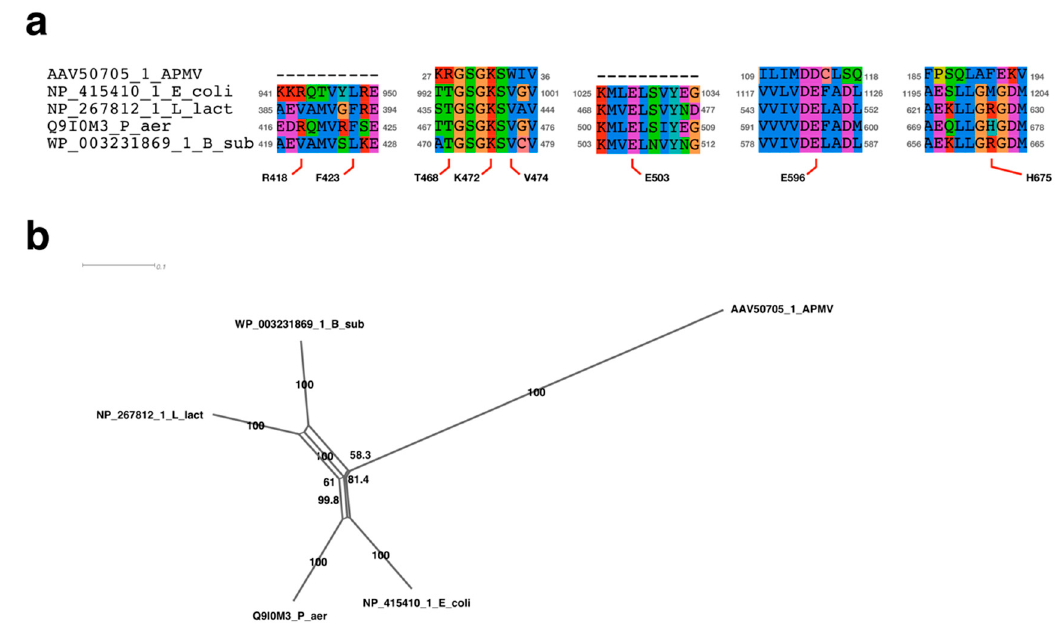
Figure 9. Sequence analyses of APMV-FtsK ATPase domain. ( a ) Motor domain of FtsK-like protein sequence alignment. Accession number and species name are labeled on the left side of alignments. Grey numbers located on both sides of the alignments indicate the exact positions of each sequence. Labels under the alignment indicate the amino acids related to ATPase activities determined in P. aeruginosa [41]. ( b ) Neighbor-Net network tree of the gamma domains. Accession number and species name correspond to the sequence alignment labeled at the end of the branch. Numbers on nearby branches indicate bootstrap test values with 1000 replicates. Scale bar: number of substitutions per